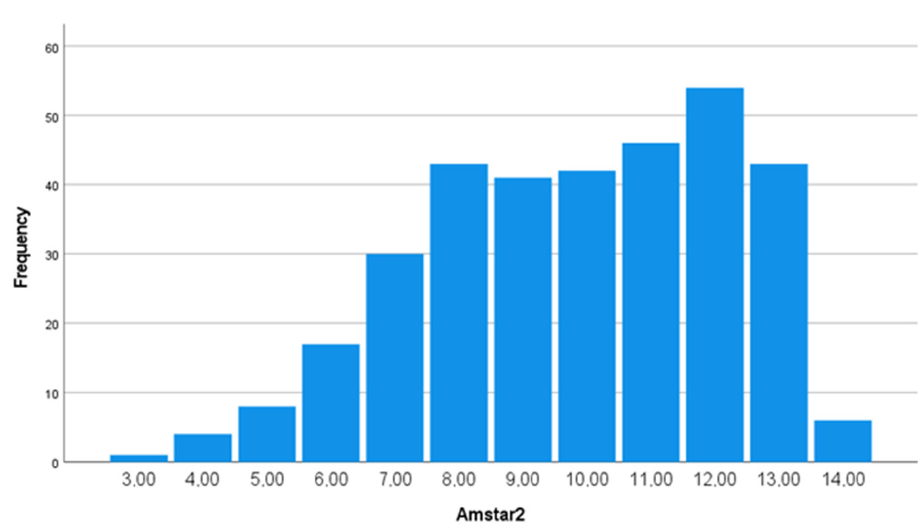
Figure 2. Histogram of the AMSTAR-2 score Frequency Distribution.